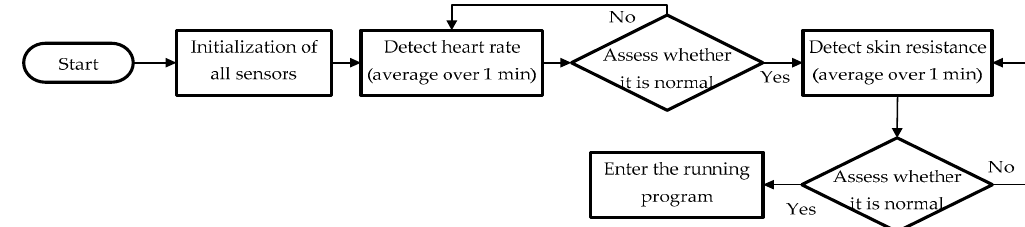
Figure 4. Workflow for collecting physiological information before running.